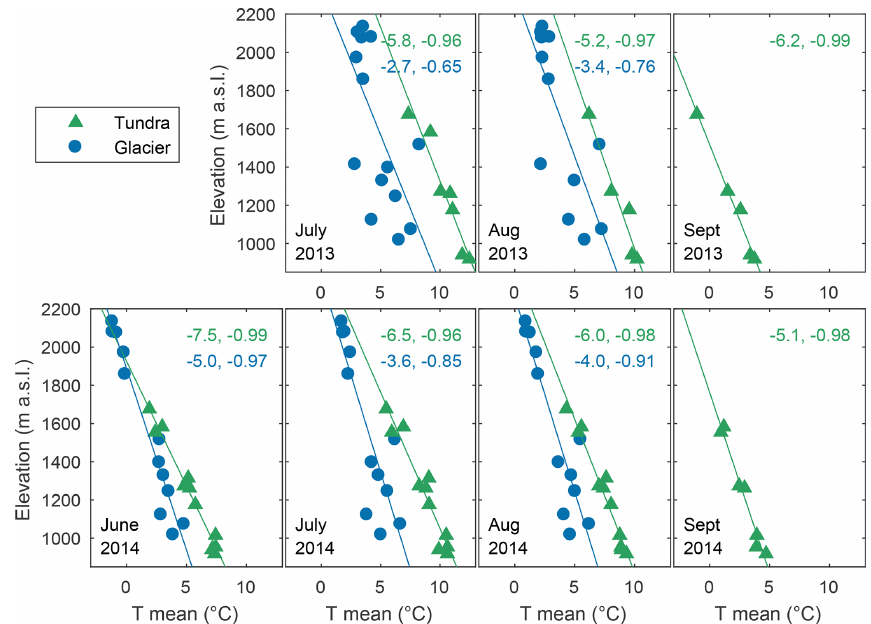
Figure 10. Monthly air temperature profiles from simple weather stations on the glaciers and on the tundra. Environmental lapse rates ( ◦ Ckm − 1 ) were calculated by linear regression between monthly average data and station elevations and are reported in the upper right of each subplot, along with the r value of the fit.